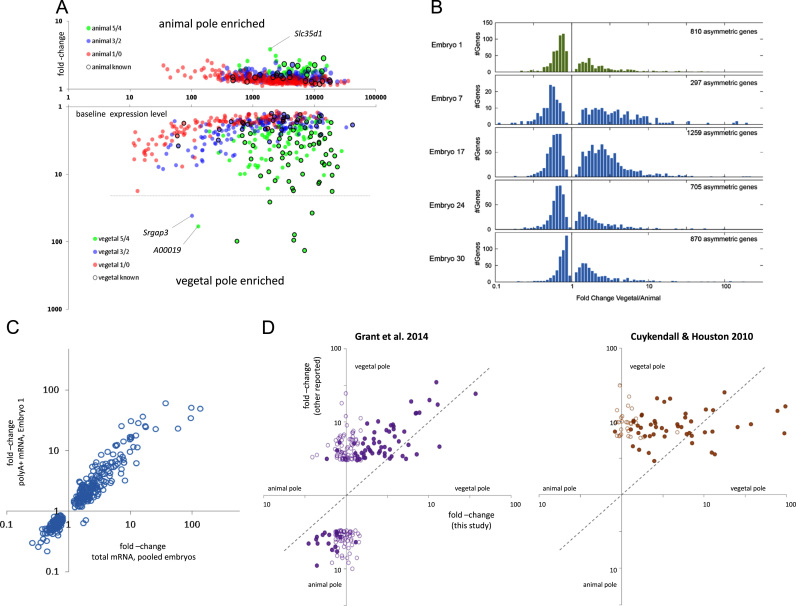
Variation in enrichment within and between studies. A. Variation of fold-change with expression level at animal and vegetal poles in this study. Scatter plot of mean expression level at the enriched pole against fold change measured between the poles for the 908 enriched genes in the pooled embryo analysis. Points are color coded according to the numbers of individual embryos in which significant asymmetric expression was detected in the single embryo analysis, see Key. Genes are clearly segregated according to the consistency of detection at the single embryo level. The much greater fold-change for vegetal pole enrichment is clearly visible (note the log scale). Genes enriched in our data and previously published are highlighted (black circles), and the most enriched novel mRNAs are indicated. B. Distribution of fold-changes at either pole for individual embryos. C. Agreement of measured fold-changes between the pooled total mRNA data and the polyA+ mRNA data of Embryo 1: Spearman correlation=0.94. D. Correlation of gene enrichment between this study and earlier work. Scatter plots of enrichment fold-change on the animal–vegetal axis for genes in this study previously reported as enriched in other studies. Left panel, blastomere data (Grant et al., 2014), right panel, oocyte data (Cuykendall and Houston, 2010). Full circles: genes enriched in present study with FDR<0.05; open circles: genes not found enriched, with FDR>0.05, fold-change in our data is simple ratio of vegetal/animal pole reads.